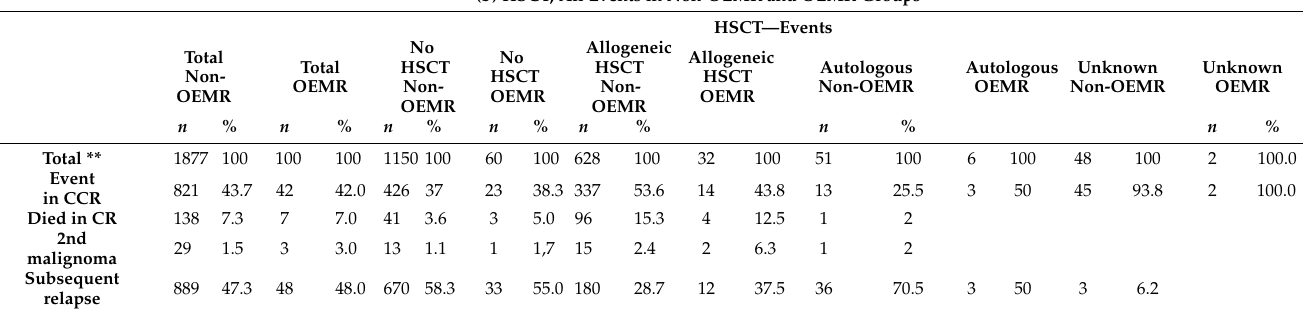
Legend to Table 4: * One patient excluded due to unknown risk group. ** Progressive disease, death in induction and death unknown excluded. Abbreviations: (C)CR, (continued) complete remission; HSCT, hematopoietic stem cell transplantation; OEM(R), other ex- tramedullary (relapse); w/o,